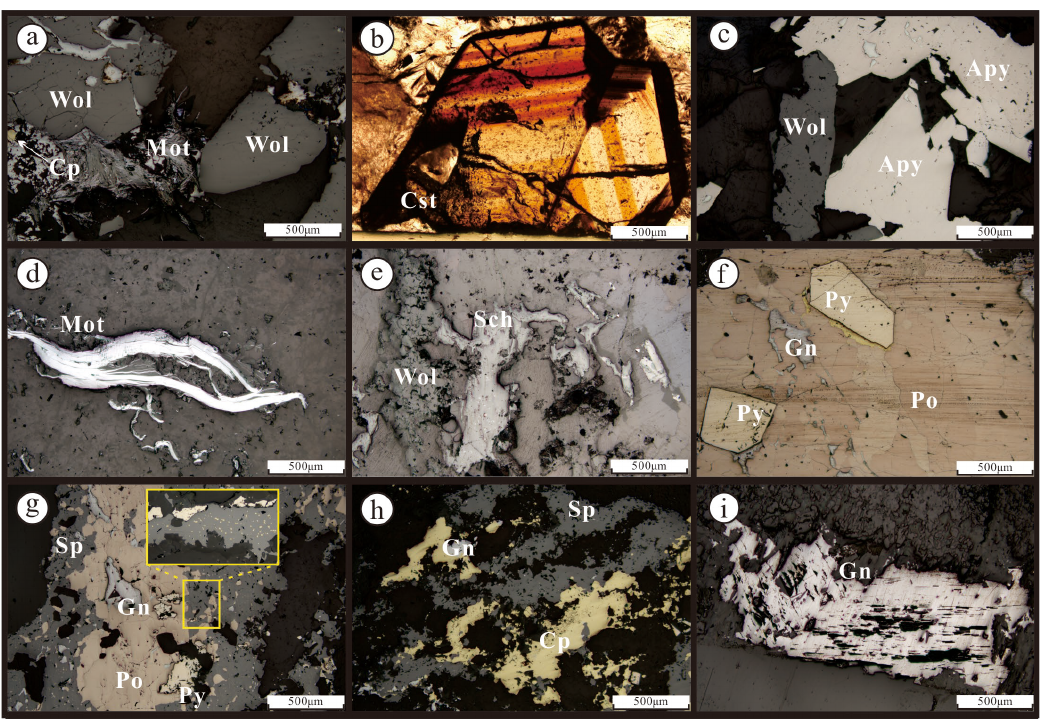
Figure 5. Photomicrographs of representative hand samples from the Hongqiling Sn-W polymetallic deposit. ( a ) Columnar wolframite with molybdenite, and chalcopyrite; ( b ) well-zoned cassiterite; ( c ) wolframite intergrown with arsenopyrite; ( d ) filamentous molybdenite in quartz vein; ( e ) wolframite intergrown with scheelite; ( f ) euhedral pyrite enclosed in pyrrhotite with minor galena; ( g ) pyrrhotite intergrown with pyrite, galena, and sphalerite with chalcopyrite disease; ( h ) chalcopyrite intergrown with sphalerite, locally visible galena; ( i ) galena deformed by external stress. Wol: wolframite; Cp: chalcopyrite; Cst: cassiterite; Apy: arsenopyrite; Mot: molybdenite; Sch: scheelite; Py: pyrite; Po: pyrrhotite; Gn: galena; Sp: sphalerite.